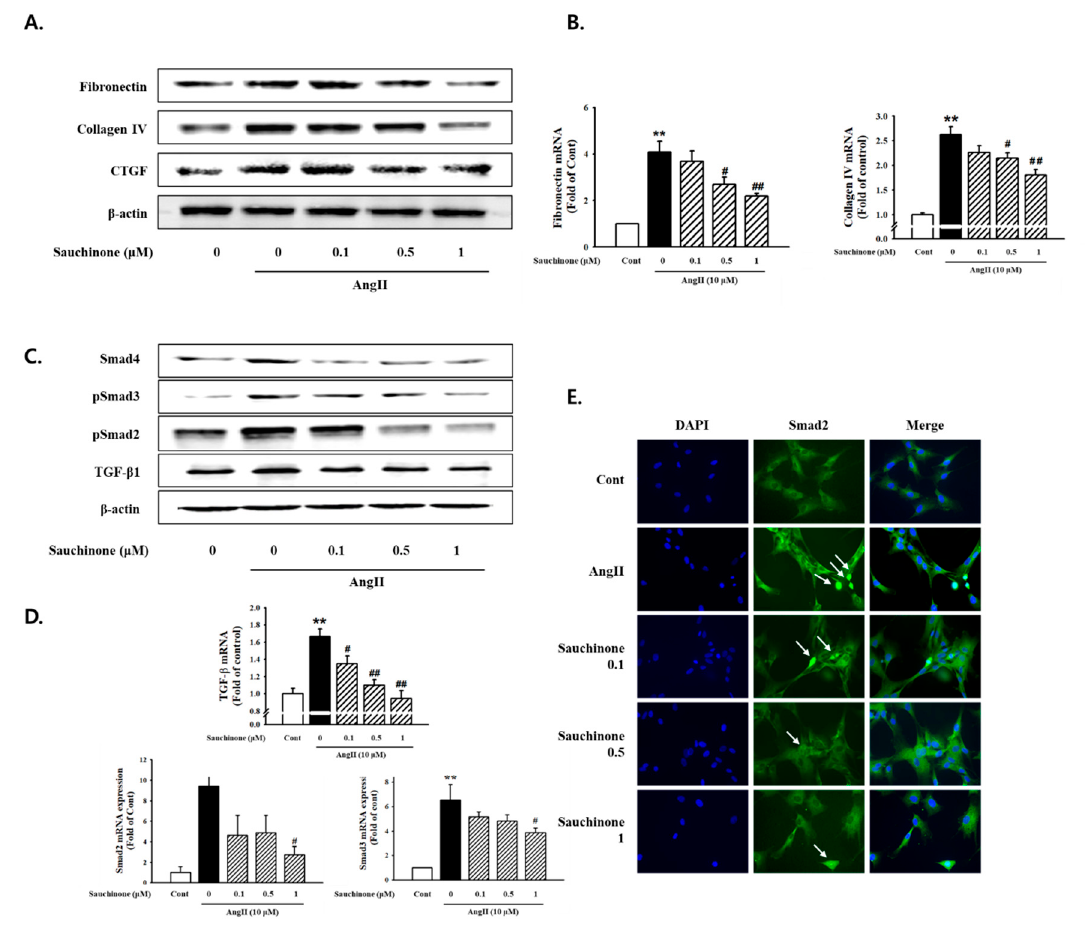
Figure 3. Effect of sauchinone on AngII-induced mesangial cell fibrosis. ( A ) Western blotting and ( B ) real-time PCR showed protein and mRNA levels of fibronectin, Collagen IV, and CTGF in sauchinone-treated and AngII-stimulated cells at 48 h. ( C , D ) Effect of sauchinone on the relative levels of TGF- β 1/Smads. The results were detected by Western blotting and real-time PCR. ( E ) Immunofluorescent images of p-Smad-2 nuclear translocation under the laser scanning confocal microscopy are show (magnification. 400×). Nuclei were stained with DAPI (blue) and p-smad-2 was stained with Alexa Fluor 488 (green). Green fluorescence indicates localization of p-Smad-2. Respective blot data were obtained from five independent experiments. Each value represents the means ± S.E. of five independent experiments. ** p < 0.01 vs. control and ## p < 0.01, # p < 0.05 vs. AngII alone.